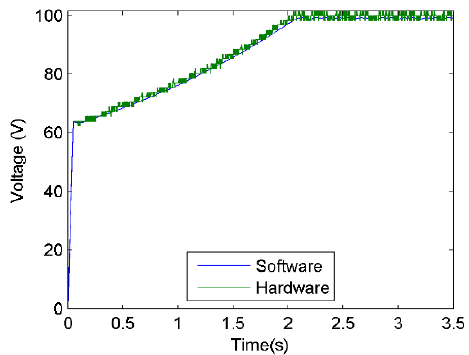
Figure 25. Response of the PVPE power with the MPPT controller emulator.